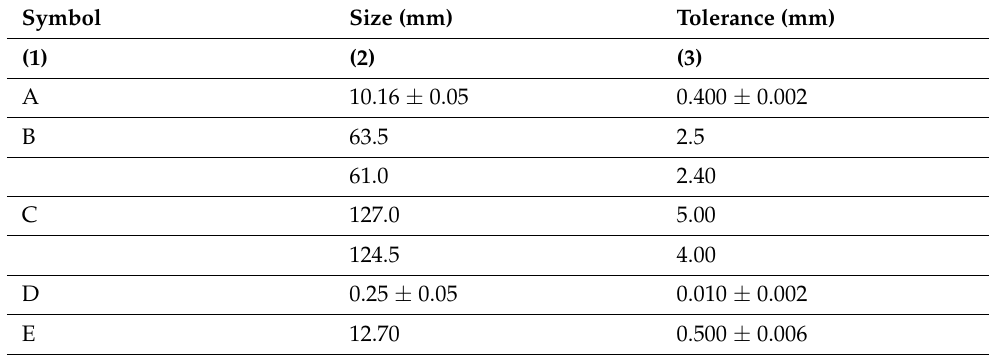
Figure 5. Impact test specimen (ASTM D6110). Table 5. Impact test specimen geometry (ASTM D6110).